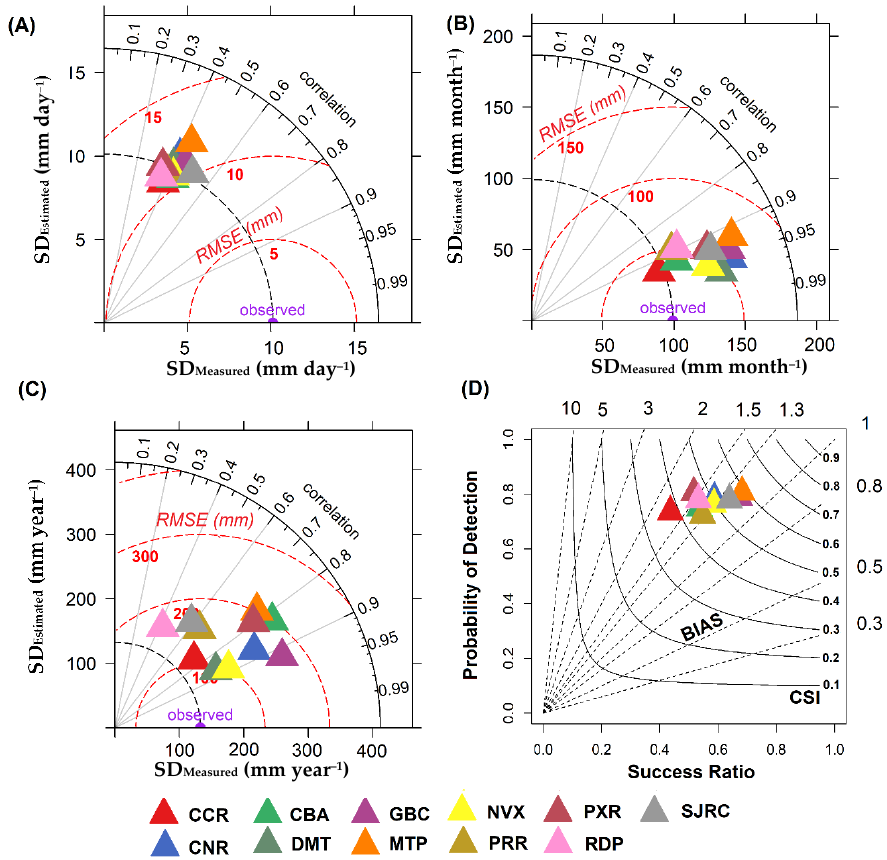
Figure 8. Taylor diagrams showing the comparisons of ( A ) daily (mm day −1 ), ( B ) monthly (mm month −1 ), and ( C ) annual (mm year −1 ) measured and estimated precipitation, as well as ( D ) the performance diagram of the TRMM product at each of the weather stations in the state of Mato Grosso, Brazil. In panels ( A – C ), the Pearson correlation coefficient (r) was represented by the azimuth angle (black outlines), the RMSE was represented by the red dashed outlines, and the standard deviation (SD) was indicated by the x and y axes, respectively. In panel ( D ), the probability of detection (POD) is represented on the x and y axes; the BIAS was indicated by the dashed black lines; and the critical success index (CSI) was represented by continuous black lines. For ( A ), the daily values for the entire study period were averaged, while for ( B ), the total monthly values for all months during the study period were averaged, and the annual values in ( C ) were the annual values averaged for all years during the study period.